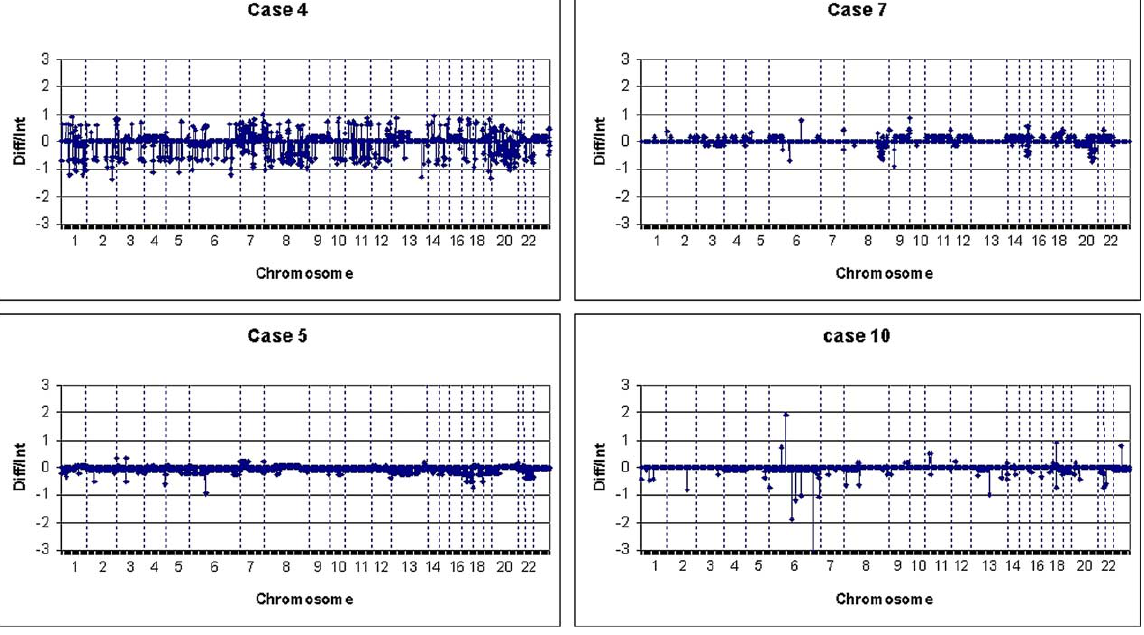
rations in the intestinal component were more